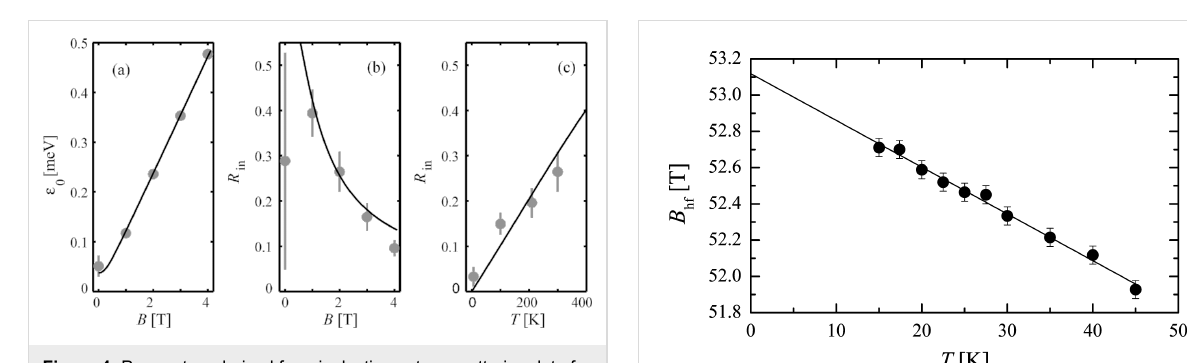
Figure 4: Parameters derived from inelastic neutron scattering data for 4.0 nm particles of maghemite: (a) Energy of the satellite peaks as a function of the applied magnetic field at 300 K; (b) the relative area of the inelastic peaks as a function of the applied field at 300 K; (c) the relative area of the inelastic peaks as a function of temperature at B = 2 T. [Reprinted with permission from Lefmann, K.; Bødker, F.; Klausen,